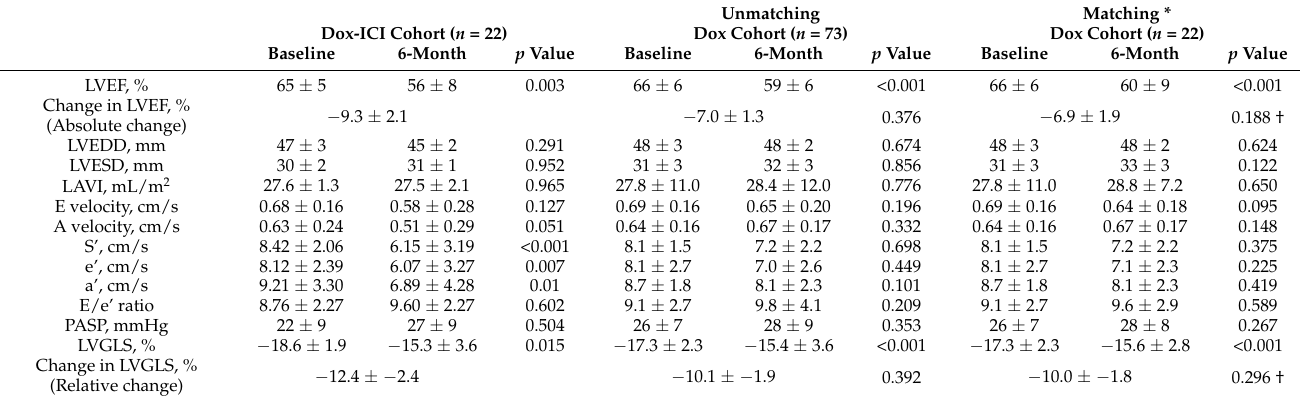
Table 2. Echocardiographic parameters at baseline and follow-up during